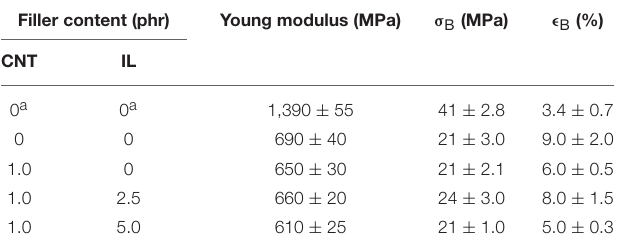
TABLE 2 | Tensile properties of PLA/EVA (60:40 wt%) composites.